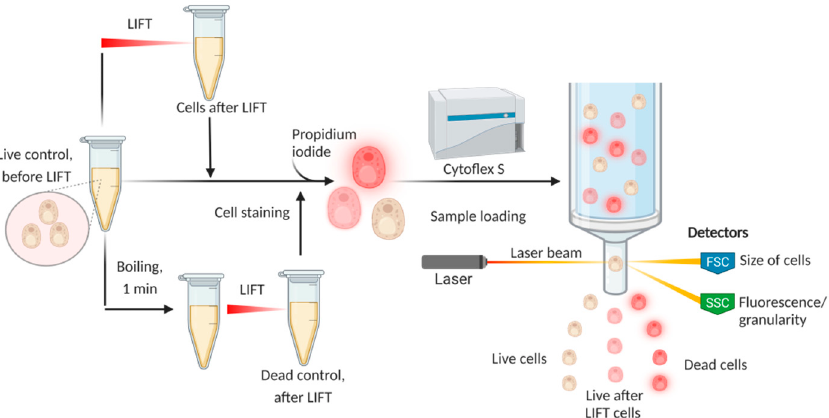
Figure 10. Schematic of the experimental setup. Created with BioRender.com.